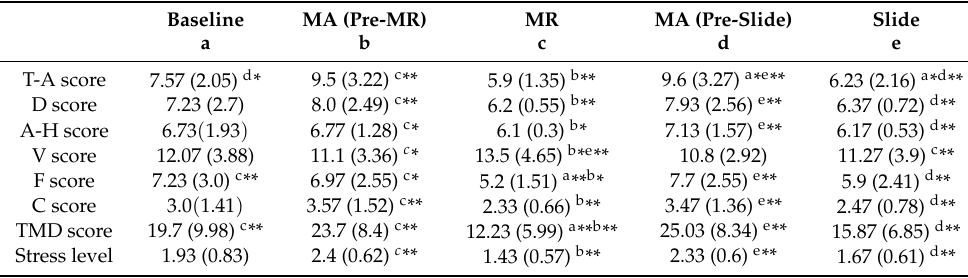
Table 3. Survey result for each sub-area in questionnaire items—mean (SD); superscripts indicate significant differences across columns; * p < 0.05; ** p < 0.01; a—baseline; b—MA (pre-MR);